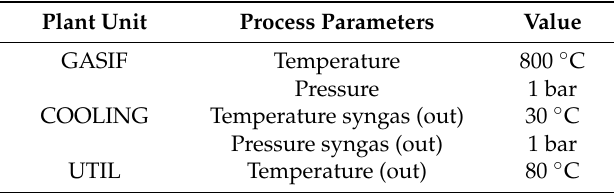
Table 6. System operating conditions.